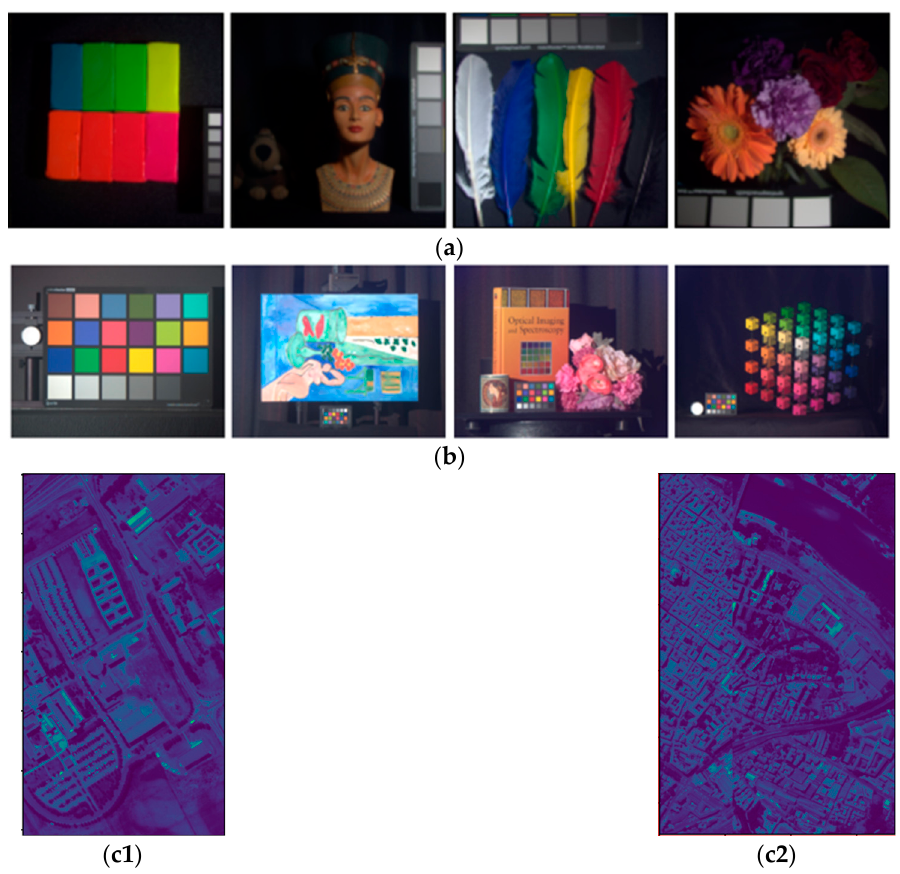
Figure 6. Representative thumbnails of each dataset. ( a ) CAVE; ( b ) KAIST; ( c1 ) Pavia_U (band55); ( c2 ) Pavia_C (band55).